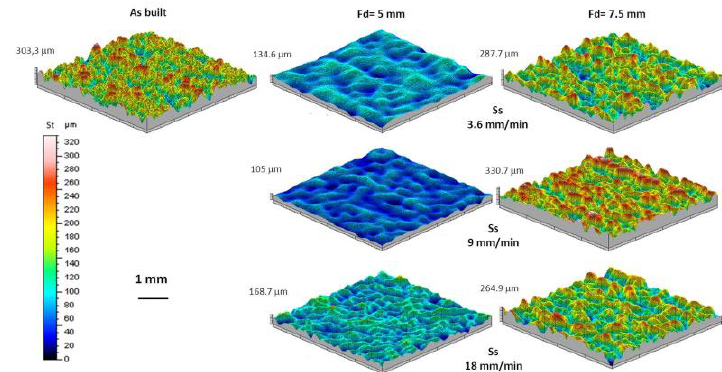
Figure 10. Roughness analysis: three-dimensional (3D) maps of the as-built and treated samples.